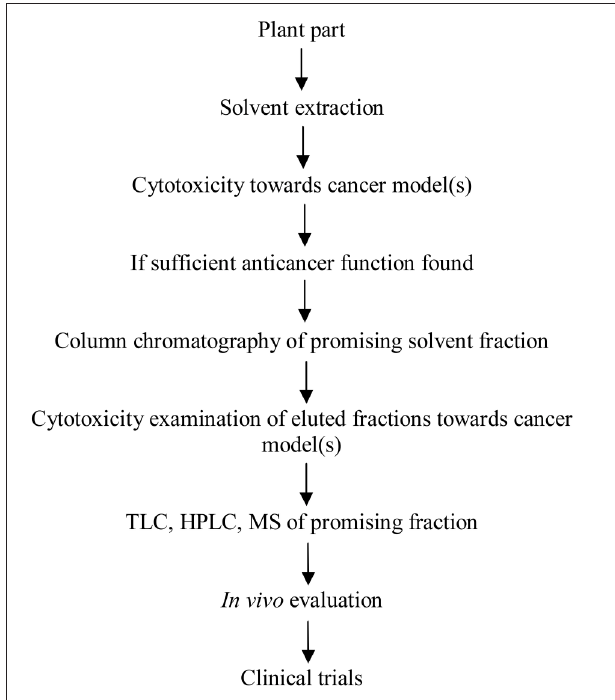
FIGURE 2 | Development of the bioactive phytomolecule(s) into an anticancer